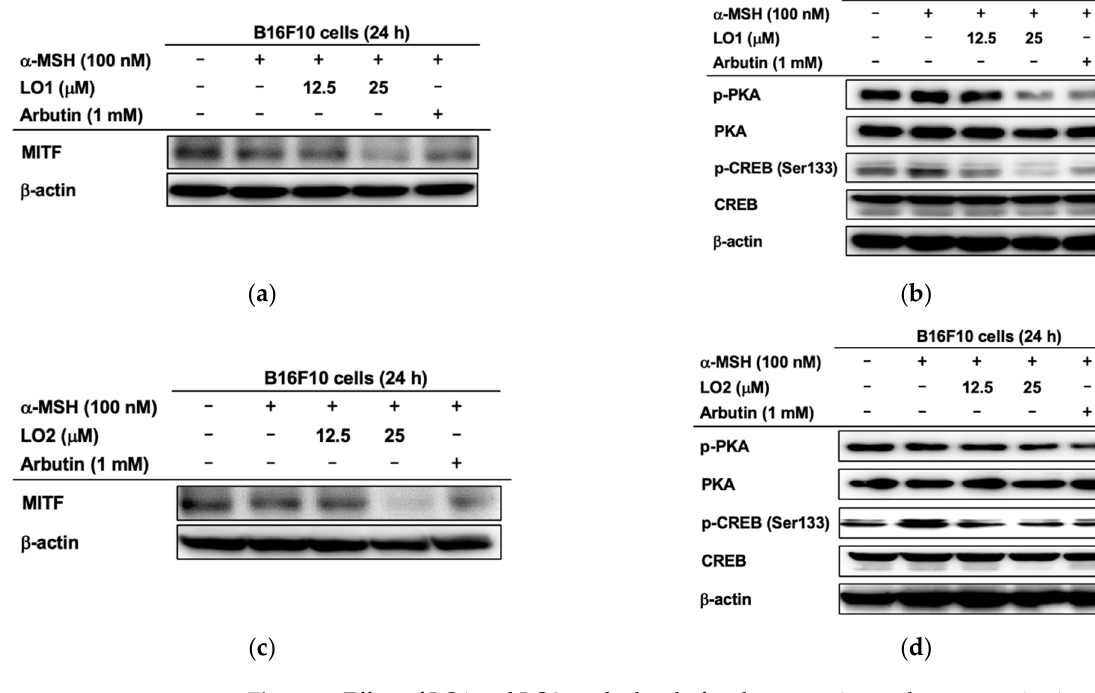
Figure 6. Effect of LO1 and LO2 on the level of melanogenesis-regulatory proteins in α -MSH-treated B16F10 melanoma cells. ( a – d ) The total or phosphorylated protein levels of melanogenesis-regulatory proteins, such as MITF, PKA, and CRAB, were detected by immunoblotting analysis.